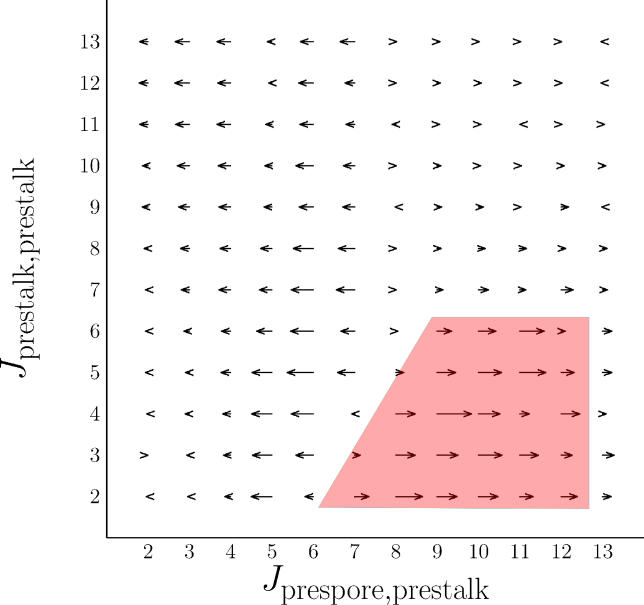
Direction of Cell Sorting of the Prestalk Cells in Simulated Dictyostelium SlugsArrows pointed toward the right indicate movement of these cells to the anterior of the slug. Cell types are: a = pacemaker, t = prestalk, p = prespore, and m = medium. In all cases, Jp,p = 11. The shaded area indicates fast-forward sorting of the prestalk cells, the left border of this area corresponding to γ = 0 (Equation 6). Parameters are Ja,a = 3, Ja,m = 7, Jt,m = 8, Jp,m = 11, Ja,t = 6, Ja,p = 9, T = 2, λ = 1, Hb = 0.8, and μ = 200; cAMP dynamics are as described in [20].